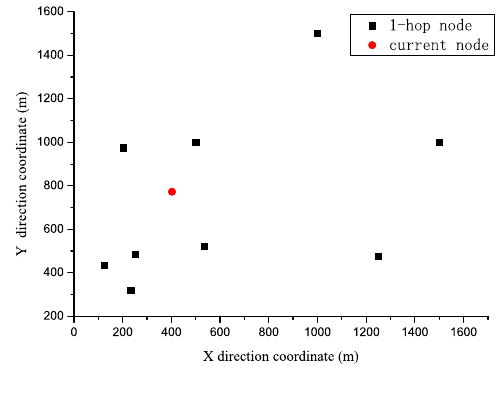
Fig.4. The locations of the neighbors.